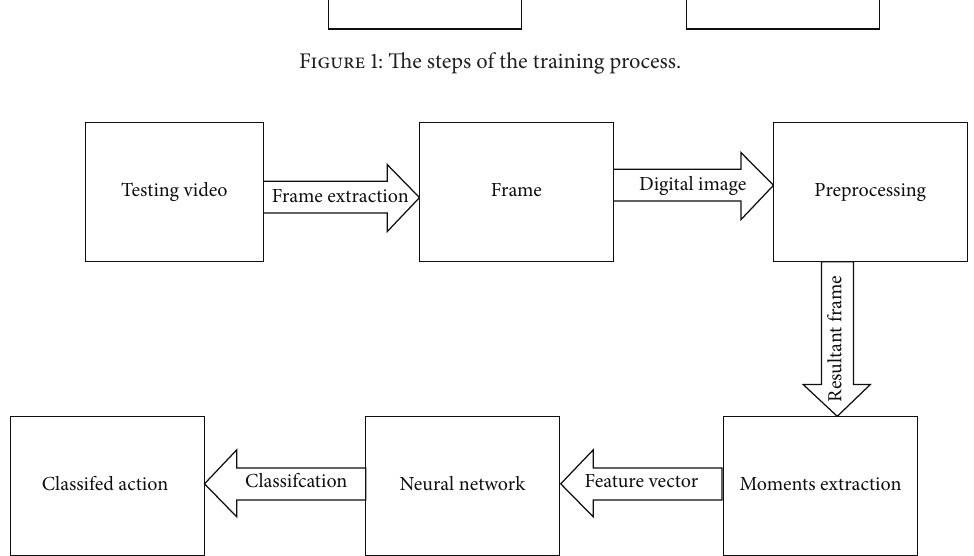
Figure 2: The classification